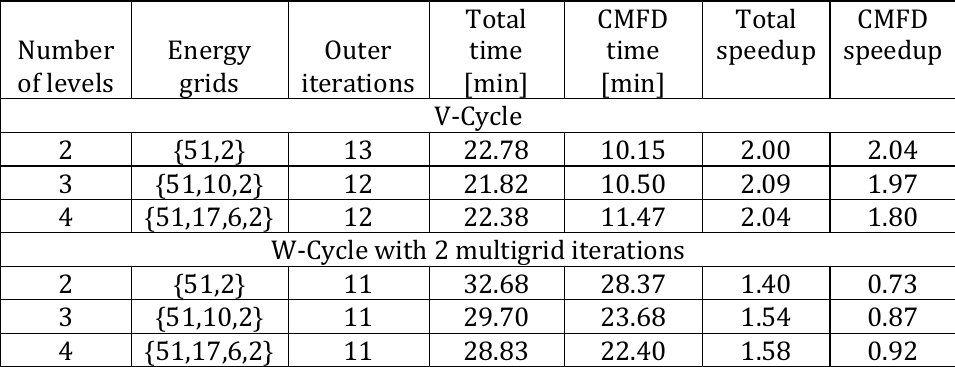
Table III. Problem 5 MLE CMFD V- and W-Cycles